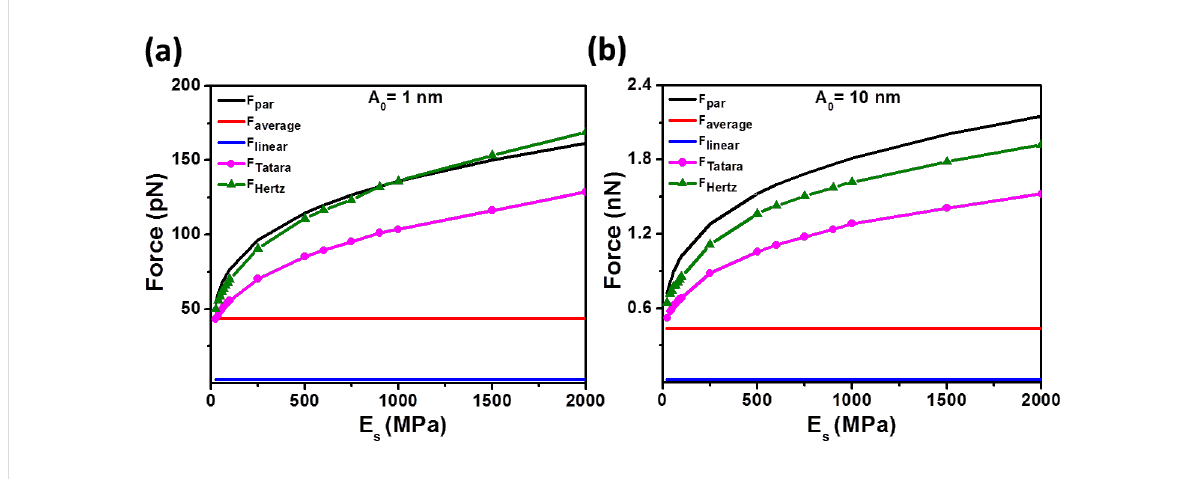
Figure 2: Peak force dependence on the Young modulus of the sample for different numerical simulations (Hertz and Tatara) and force analytical approximations (parametrized, average and linear). (a) A 0 = 1 nm, R t = 5 nm and (b) A 0 = 10 nm, R t = 5 nm. Other simulation inputs are: k = 0.1 N/m, f 0 = 25 kHz, Q = 2, R s = 4 nm, and A sp = 0.9 A 0